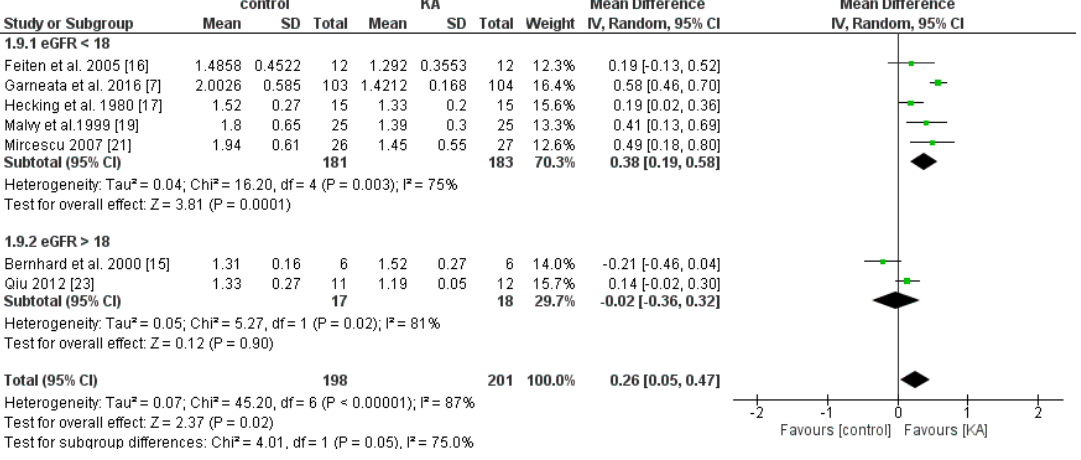
Figure 10. Forest plot of effects of KA on phosphorous in CKD patients sub-grouped by eGFR. The random-effects model was utilized.